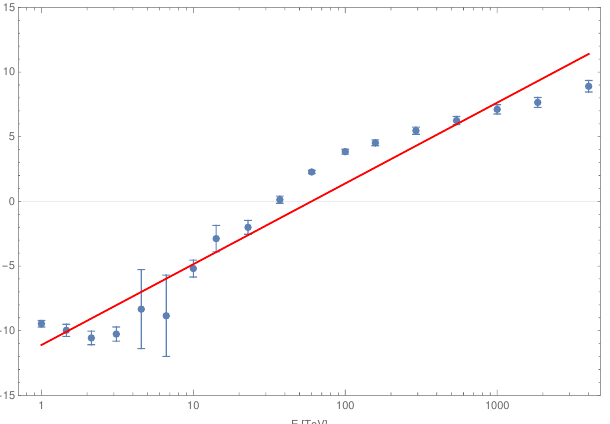
Figure A3. Values of Gaussian distribution parameter σ (for muons) for different energies of the vertical cascades and protons as the primary cosmic-ray particles.